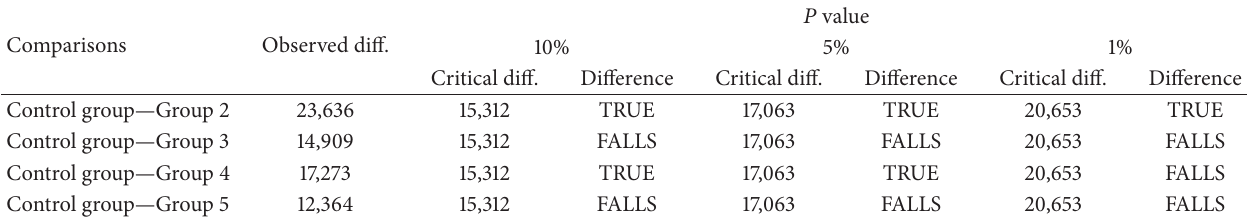
Table 2: Results of Kruskal-Wallis multiple comparison test, treatment groups versus control (two-tailed).